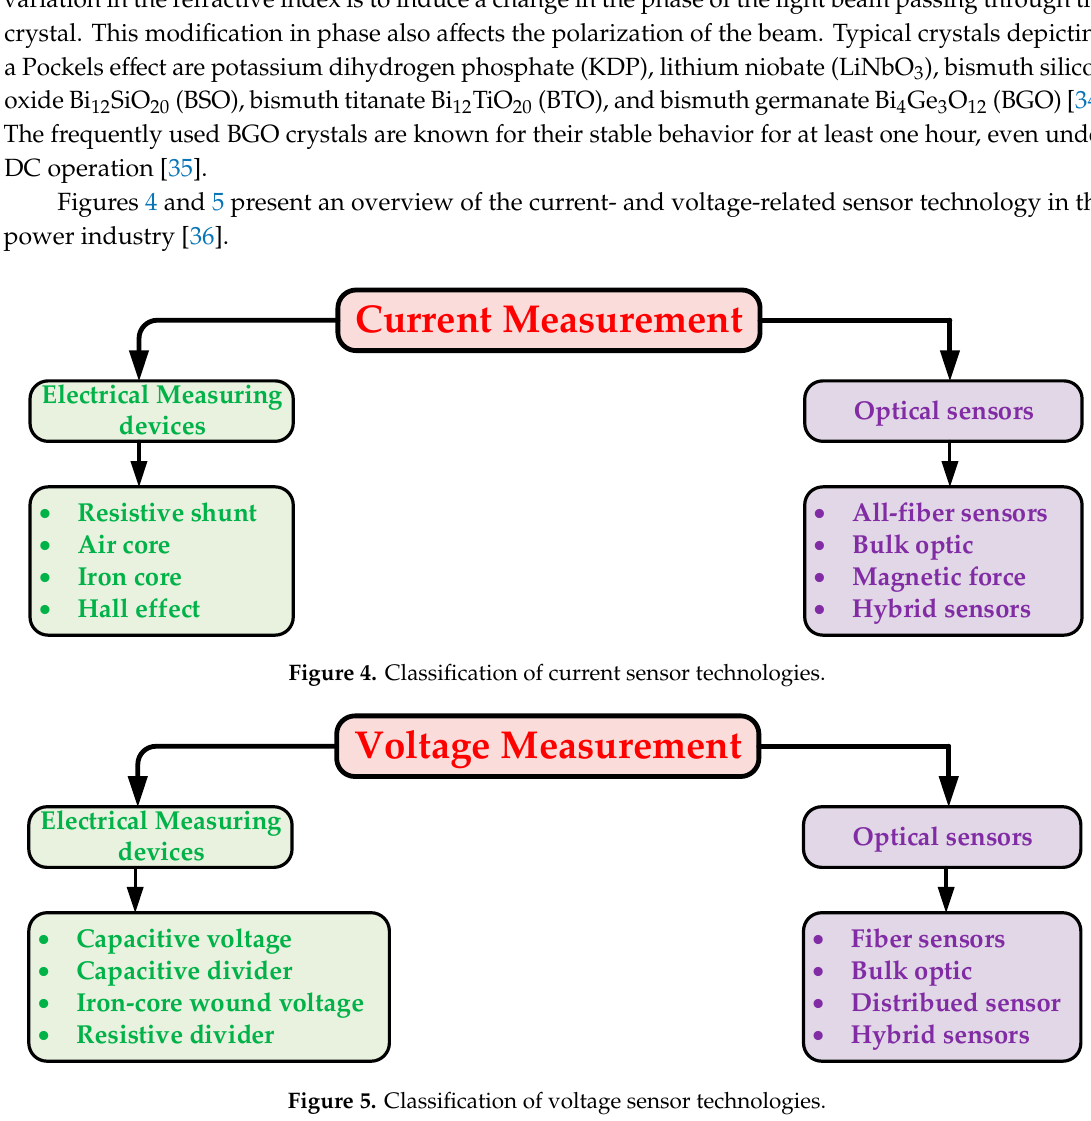
Figure 5. Classification of voltage sensor technologies.